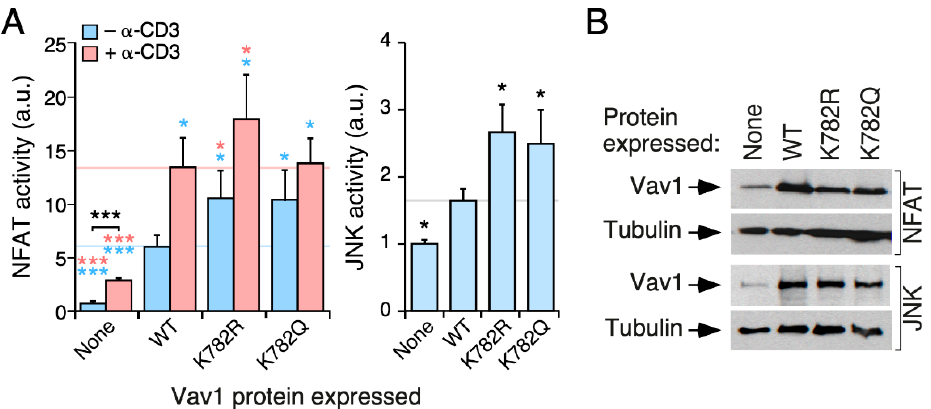
Figure 7. Acetylation- and deacetylation-mimicking mutations targeting the Lys 782 residue promote the stimulation of Vav1 downstream signaling in the absence of TCR stimulation. ( A ) Activation of NFAT (left panel) and JNK (right panel) by indicated Vav1 proteins in nonstimulated and TCR-stimulated Jurkat cells. Data represent the mean ± SEM. Statistical values were obtained using the Wilcoxon matched-pairs signed rank test. Blue and salmon asterisks indicate the significance level compared with nonstimulated and TCR-stimulated Vav1 WT -expressing cells, respectively. n = 3 (NFAT assays) and 4 (JNK assays) independent experiments, each performed in triplicate. ( B ) Representative immunoblots showing the abundance of the ectopic Vav1 proteins and endogenous tubulin α in the experiments shown in A. *, p < 0.05; ***, p < 0.001.